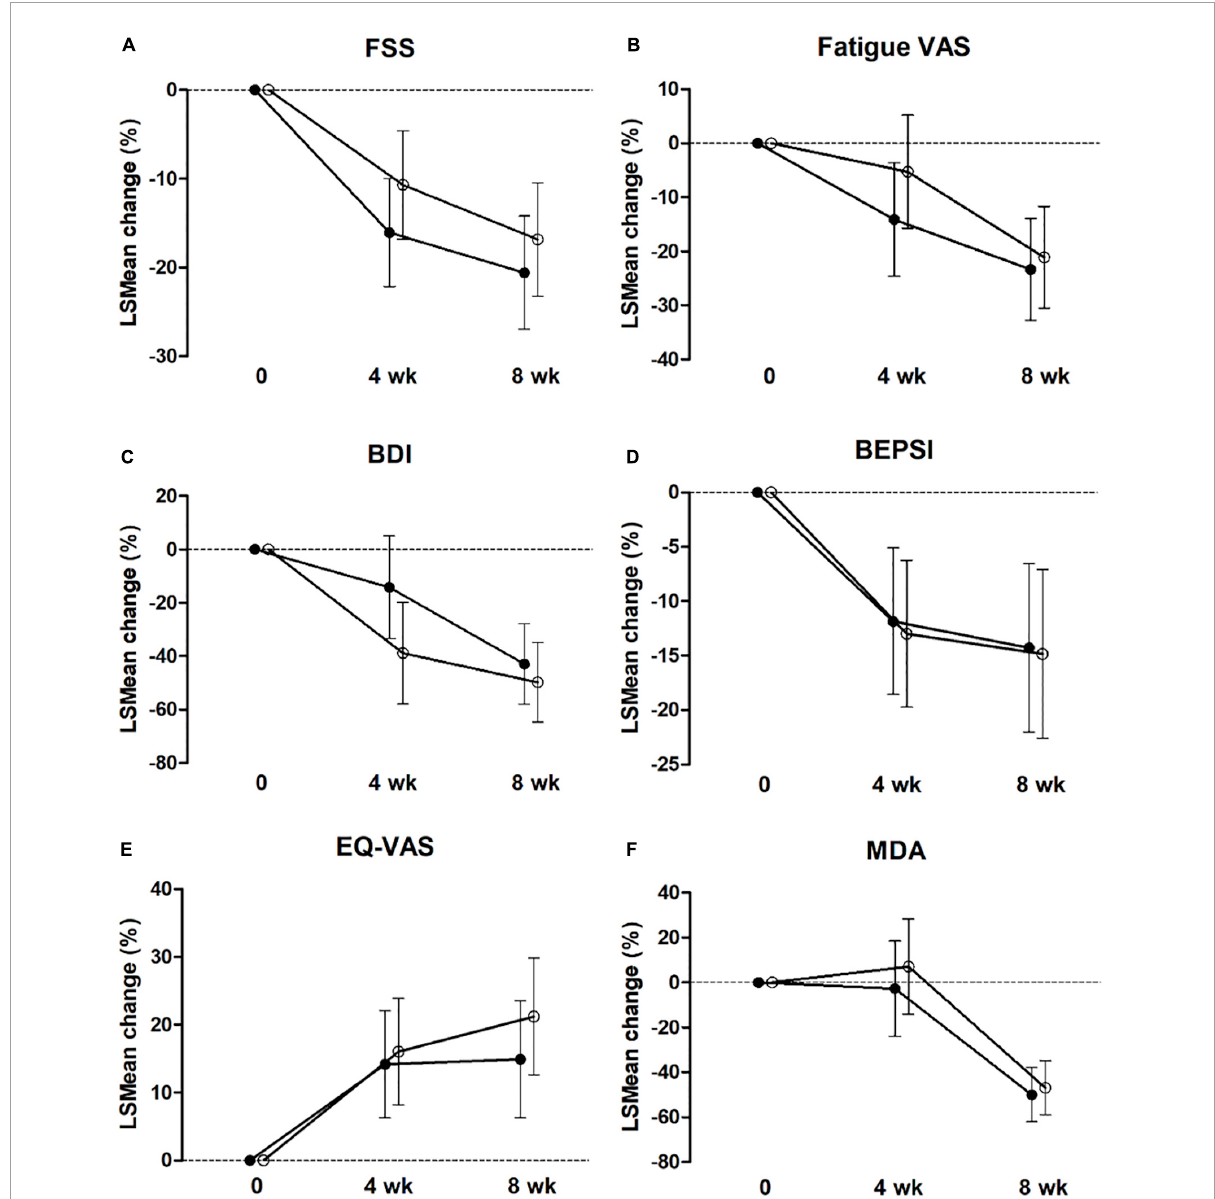
FIGURE2 Estimated marginal mean (LS mean) change from baseline to 4 and 8 weeks for FSS (A) , Fatigue VAS (B) , BDI (C) , BEPSI-K (D) , EQ-VAS (E) , and MDA (F) in the placebo group ( ◦ ) and PV group ( • ) by intent-to-treat analysis. Values are LSmean ± 95% CI. FSS, Fatigue Severity Scale; VAS, visual analog scale; BDI, the Beck Depression Inventory, BEISI-K, the Korean version of the Brief Encounter Psychosocial Instrument; EQ-VAS, Euro-QoL-VAS; MDA,